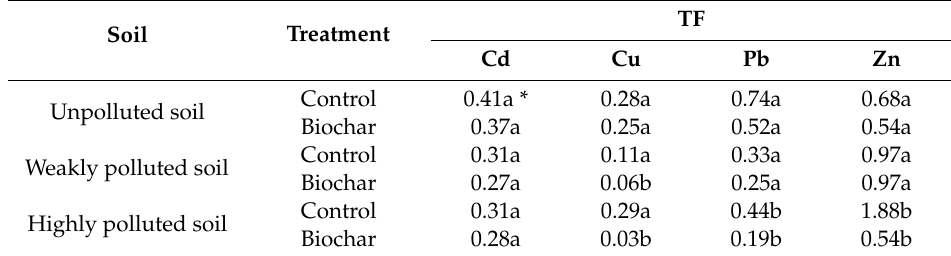
Table 4. Translocation factor (TF) calculated for barley grown in three di ff erently polluted soils amended or not with biochar (2% by weight). Soil